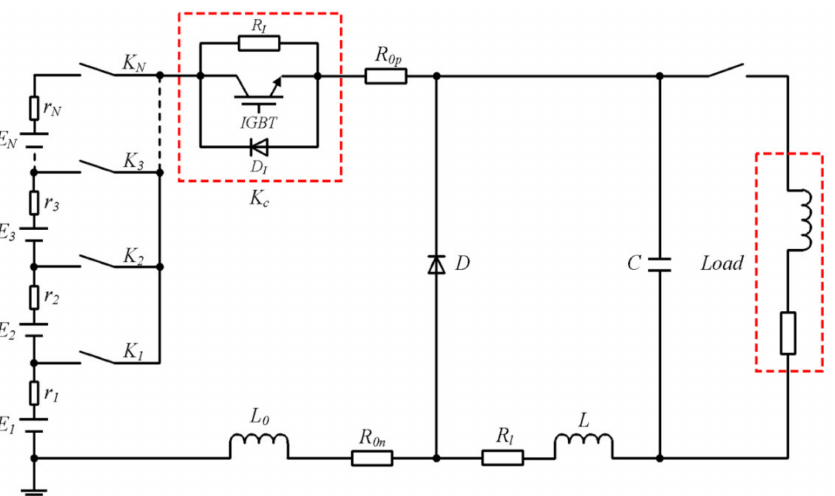
Figure 1. Diagram of the simplified circuit of the battery-pulse capacitor-based hybrid energy storage system.